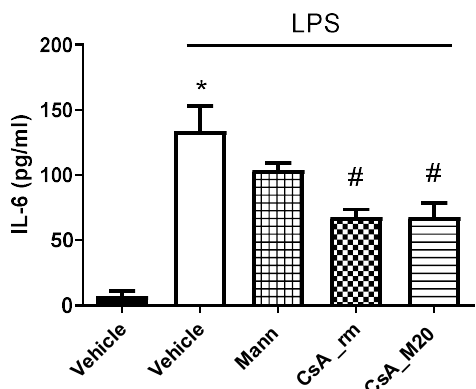
Figure 6. In vitro inhibition of IL-6 production by THP-1/A549 co-culture exposed to LPS in the presence of the vehicle, CsA_rm at 10 µg/mL, CsA_M20 at 10 µg/mL of CsA, or mannitol (Mann) at 2 µg/mL; * p < 0.05 vs. vehicle; # p < 0.05 vs. vehicle + LPS, ANOVA test followed by Bonferroni’s post-test.